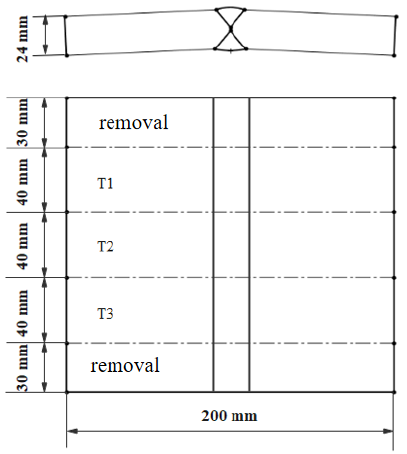
Figure 6. The sampling of the welded joints.